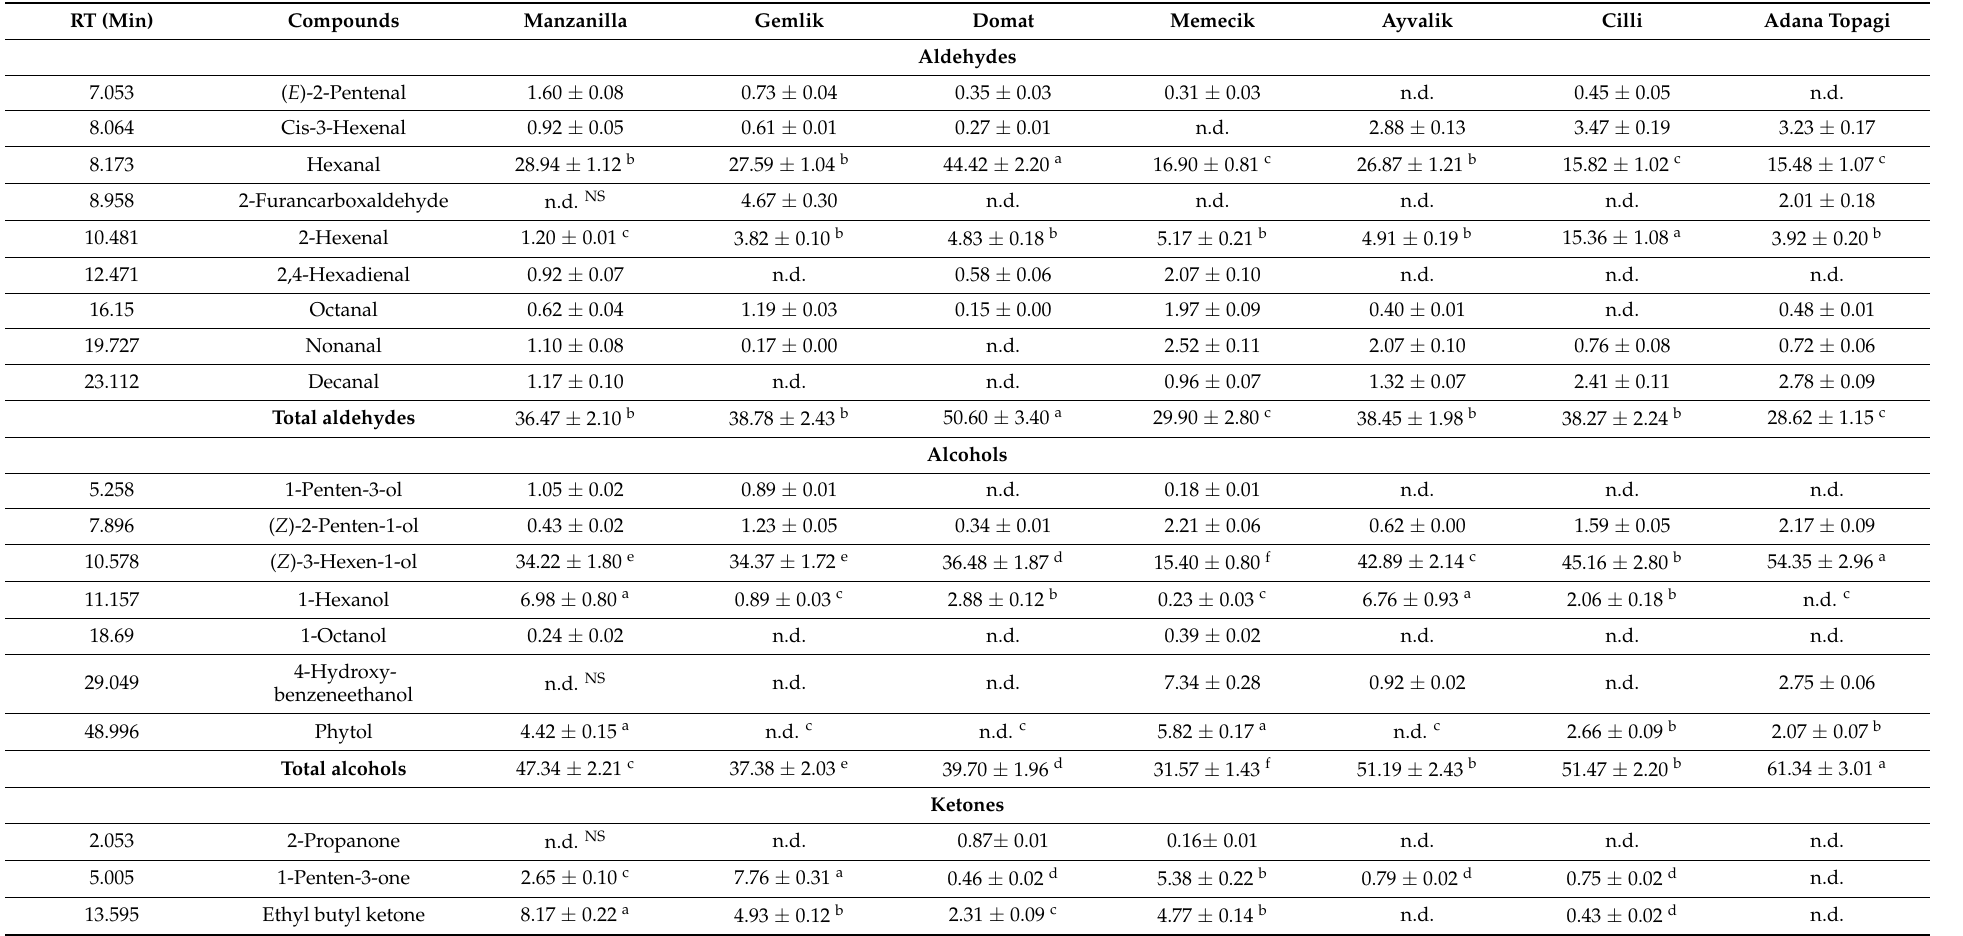
Table 5. Profile of volatile compounds for the seven olive cultivars